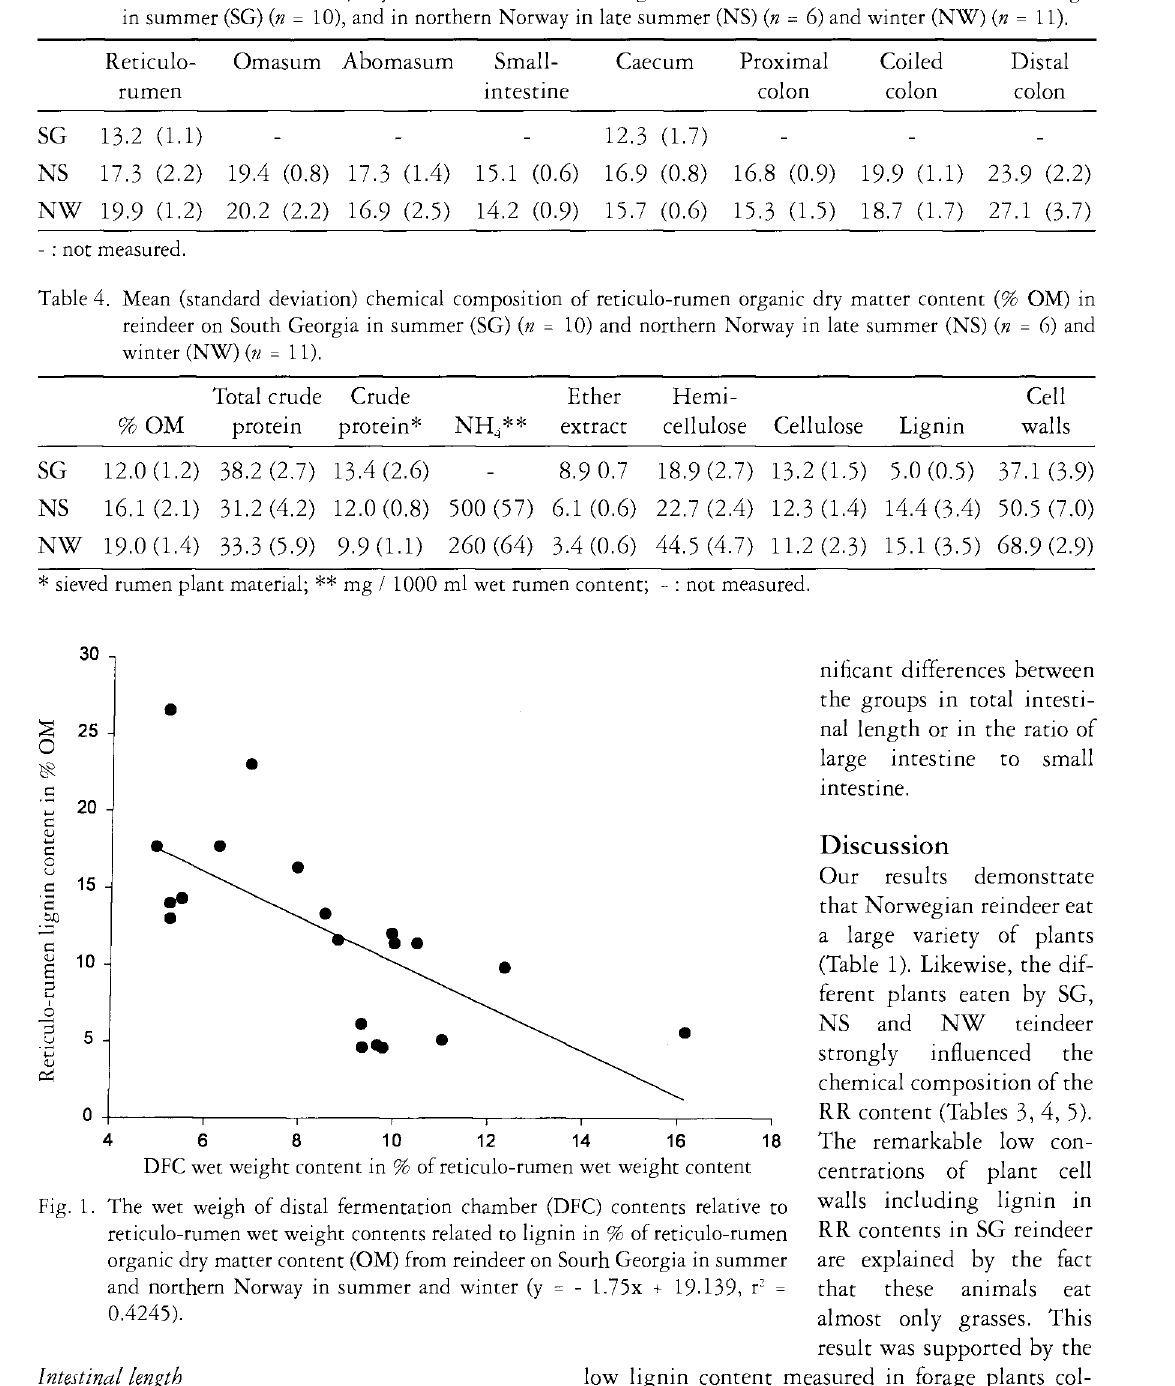
Fig. 1. The wet weigh of distal fermentation chamber (DFC) contents relative to reticulo-rumen wet weight contents related to lignin in % of reticulo-rumen organic dry matter content (OM) from reindeer on Sourh Georgia in summer and northern Norway in summer and winter (y